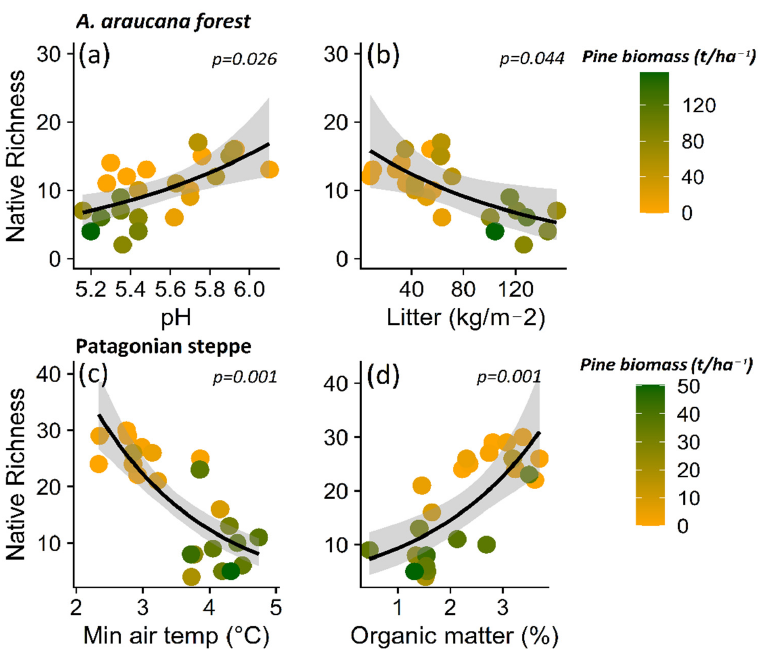
Figure 6. Relationship between native plant species richness and pH ( a ) and litter content ( b ) for Araucaria araucana forest, and the relationship between native plants and minimum air temperature ( c ) and percentage organic matter (%) ( d ) for the Patagonian steppe. The lines show the linear model fit and the 95% confidence interval and the color gradient at the points corresponds to the biomass gradient of Pinus contorta .